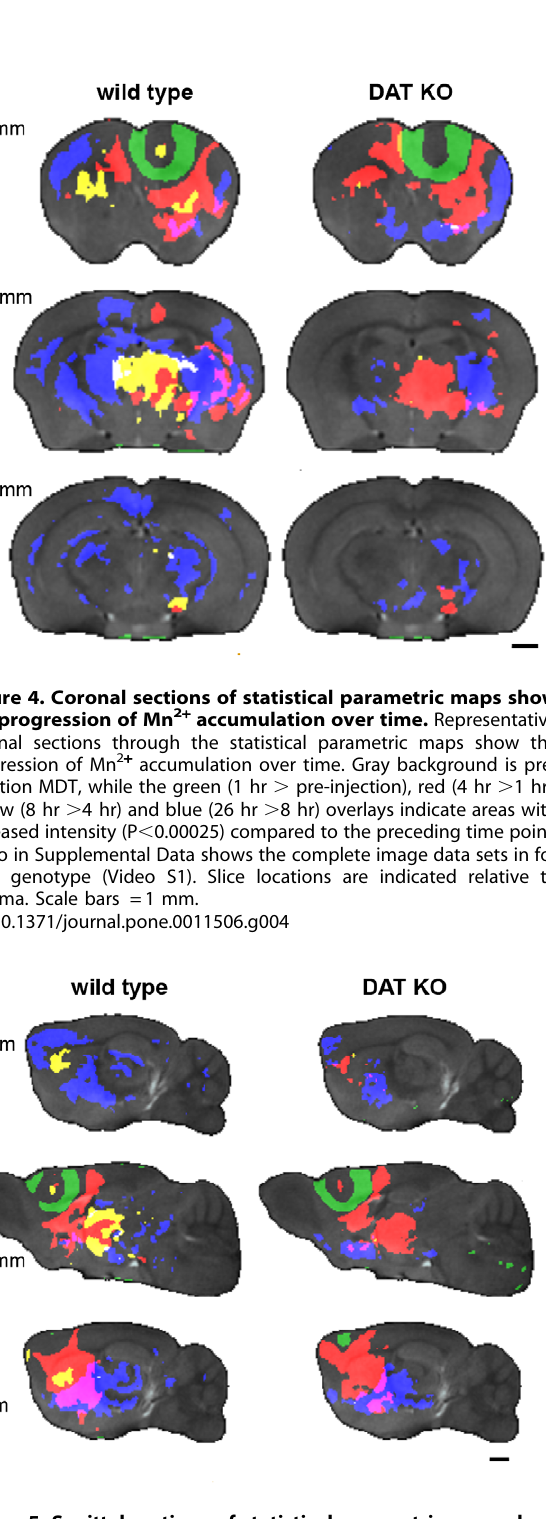
Figure 5. Sagittal sections of statistical parametric maps show the progression of Mn 2 + accumulation over time. Representative sagittal sections through the statistical parametric maps show the progression of Mn 2 + accumulation over time. Gray background is pre- injection MDT, while the green (1 hr . pre-injection), red (4 hr . 1 hr), yellow (8 hr . 4 hr) and blue (26 hr . 8 hr) overlays indicate areas with increased intensity (P , 0.00025) compared to the preceding time point. Video in Supplemental Data shows the complete image data set for each genotype (Video S2). Slice locations are indicated relative to the midline. Scale bars =1 mm.